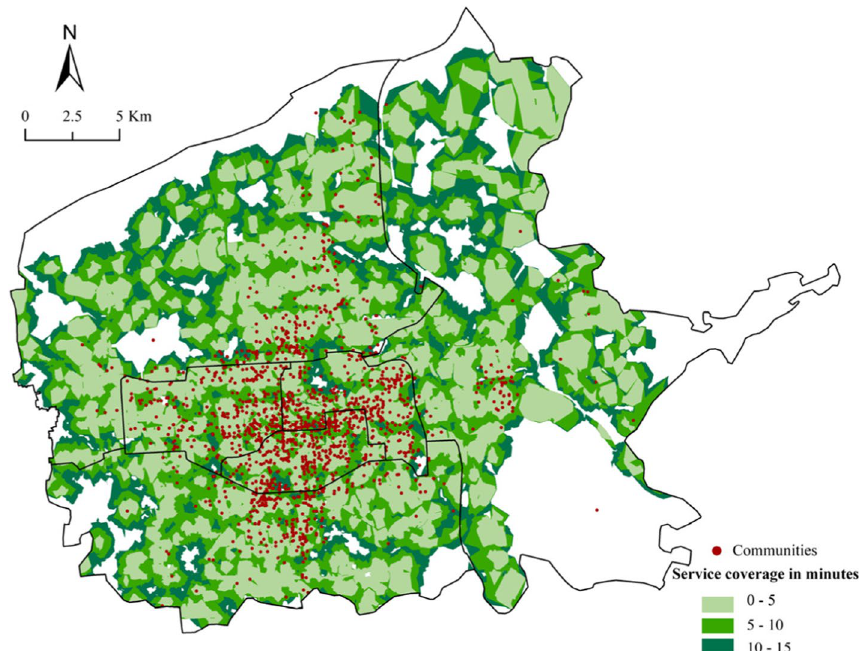
Fig. 7 Various accessibility modes in terms of service coverage area by time